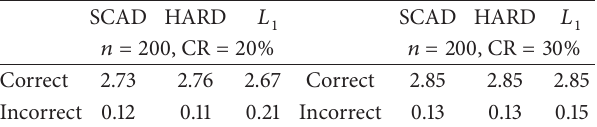
Table 1: Results of the simulation study for scenario (I). Here “correct” is the average true positive rate and “incorrect” is the average true negative rate.